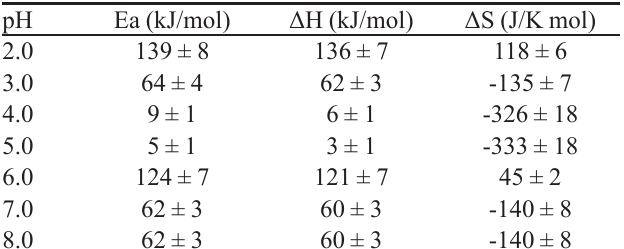
TABLE I - Energy of activation (Ea), enthalpy (ΔH) and entropy (ΔS) of stem bromelain in the studied pH